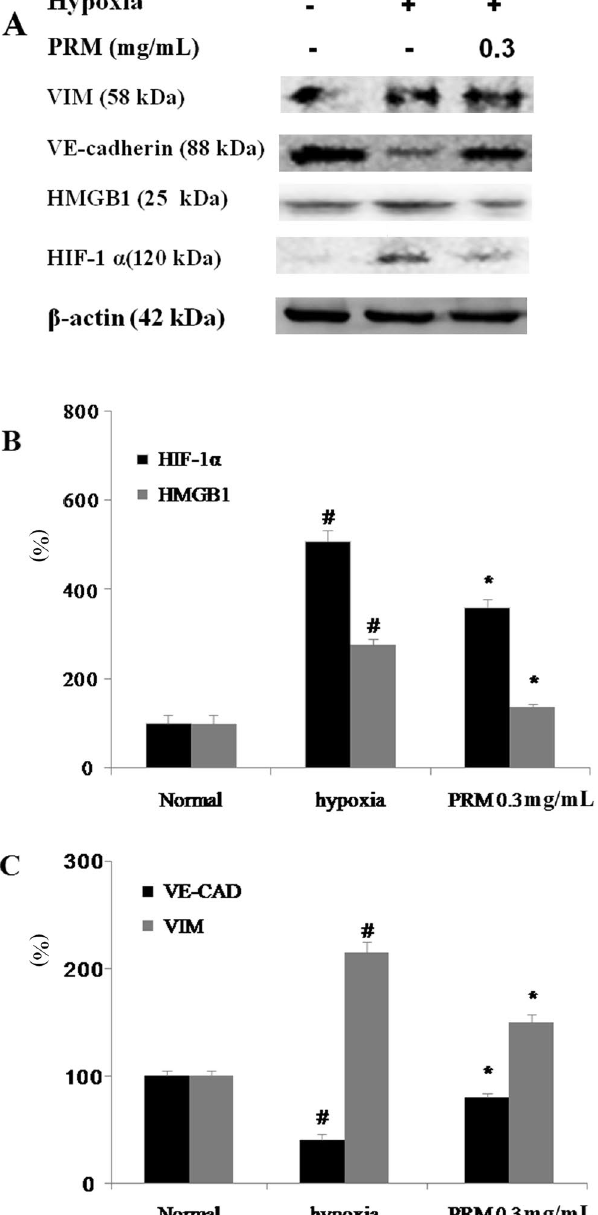
Figure 3. Effects of PRM on EndoMT in HPMECs. ( A–C ) HPMECs were incubated under hypoxic conditions for 48 h. Representative western blots of VE-cadherin, VIM, HMGB1 and HIF-1 α . All data are shown as the mean ± S.D., # P < 0.01 vs. the normal group; * P < 0.05, ** P < 0.01 vs. the hypoxia stimulated group.